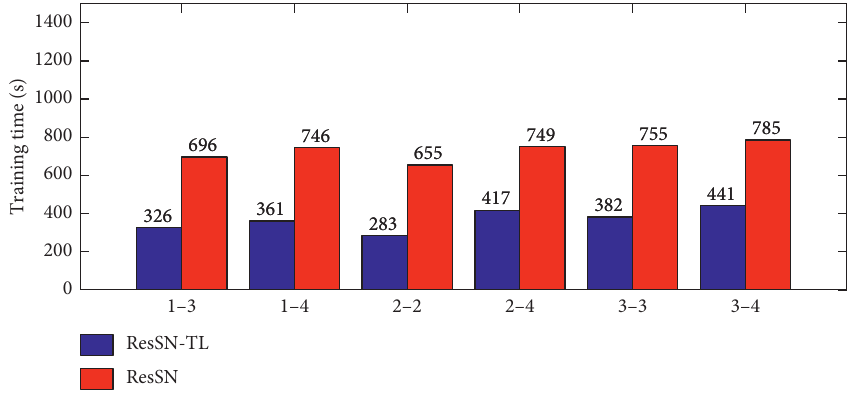
Figure 8: Training time of ResSN and ResSN-TL.